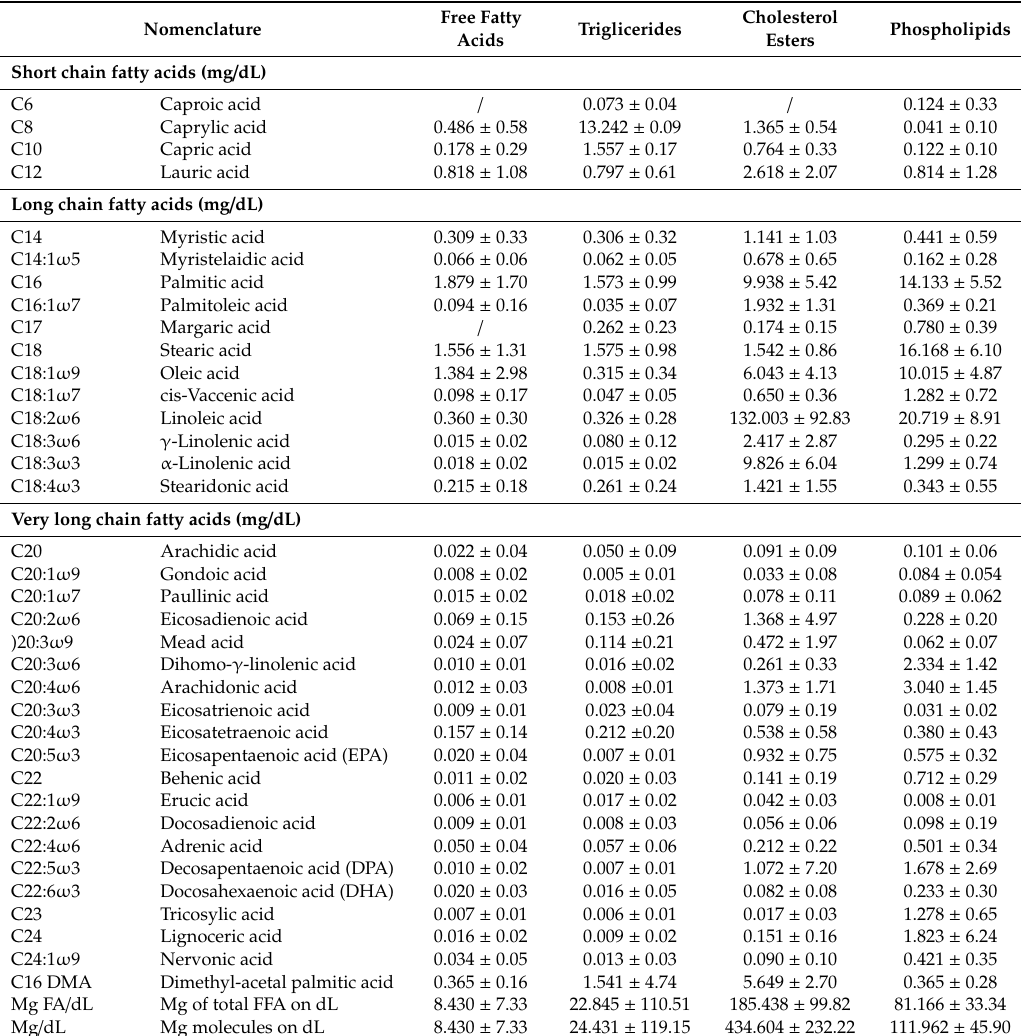
Table 3. Mean value ( ± SEM) plasma fatty acids analyzed in the four lipid classes